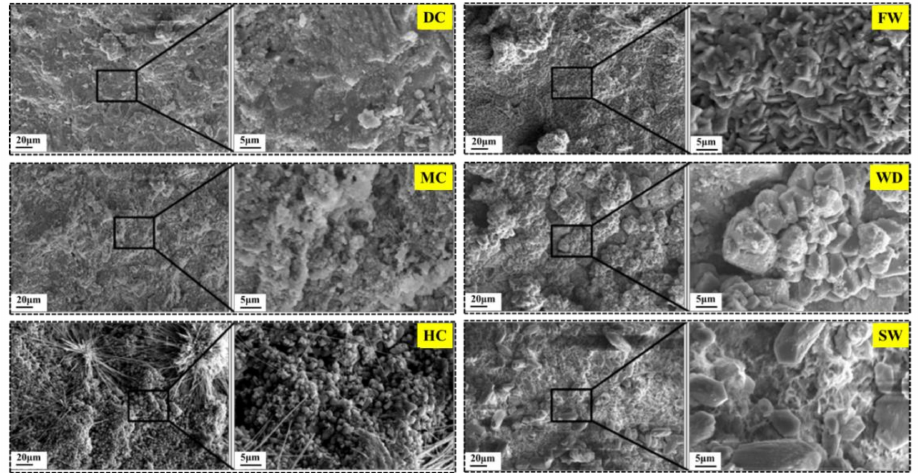
Figure 16. SEM of self-sealing product for samples cured in different conditions.